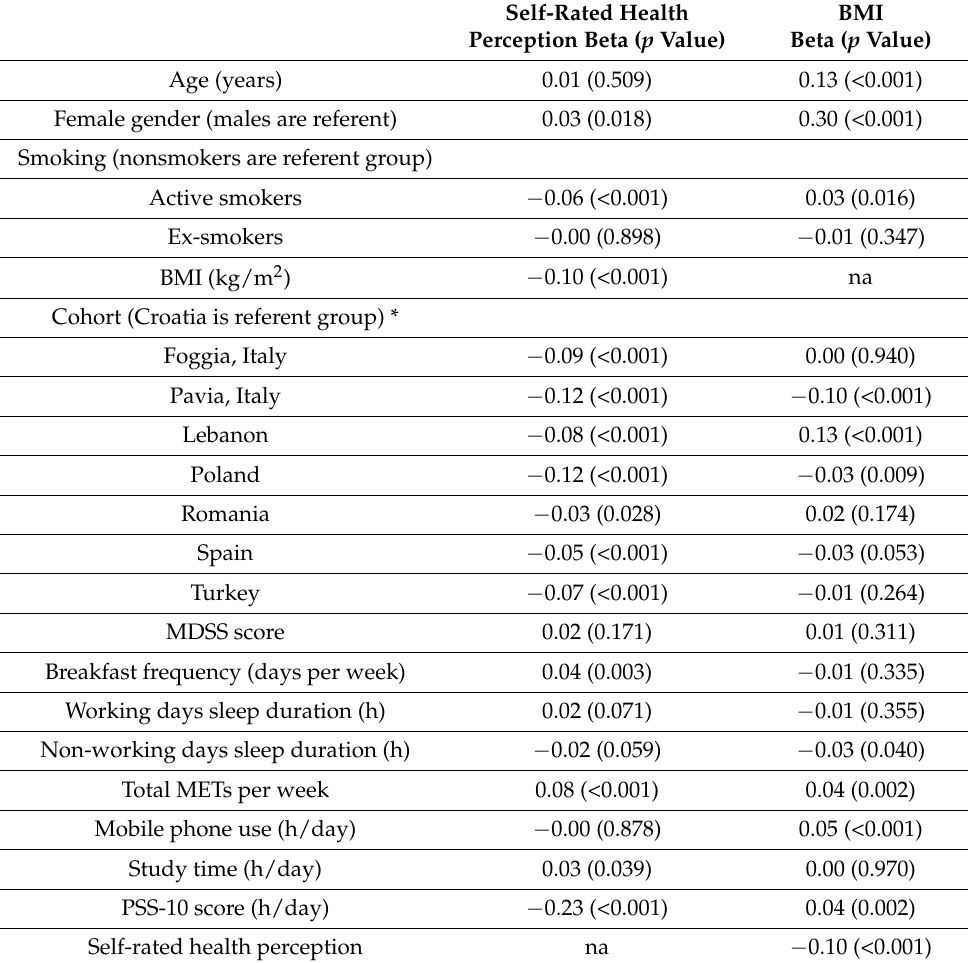
Table 3. Association between lifestyle habits and self-rated health perception and BMI in the overall sample of students (multivariable linear regression